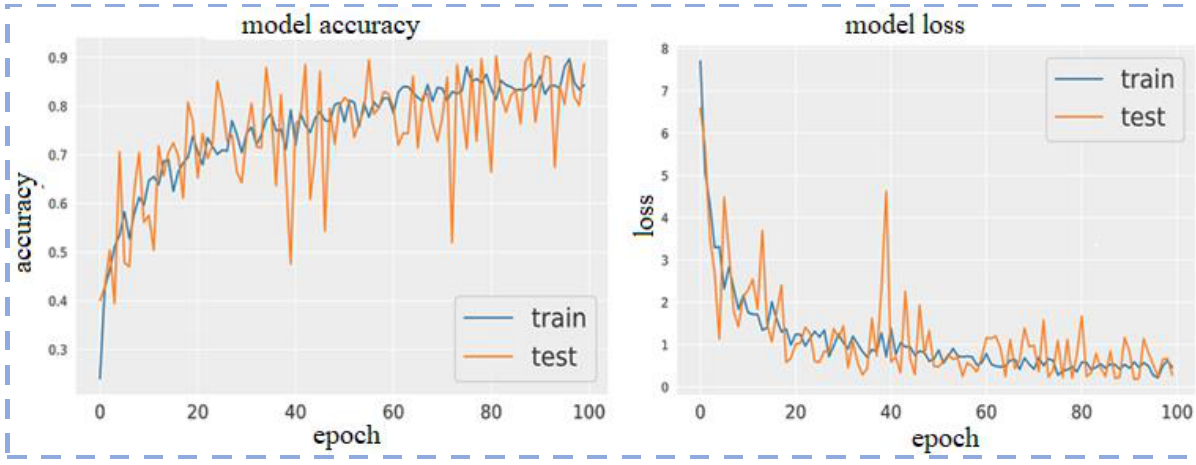
Figure 6. Model loss and model accuracy using ResNet101. Figure 7.